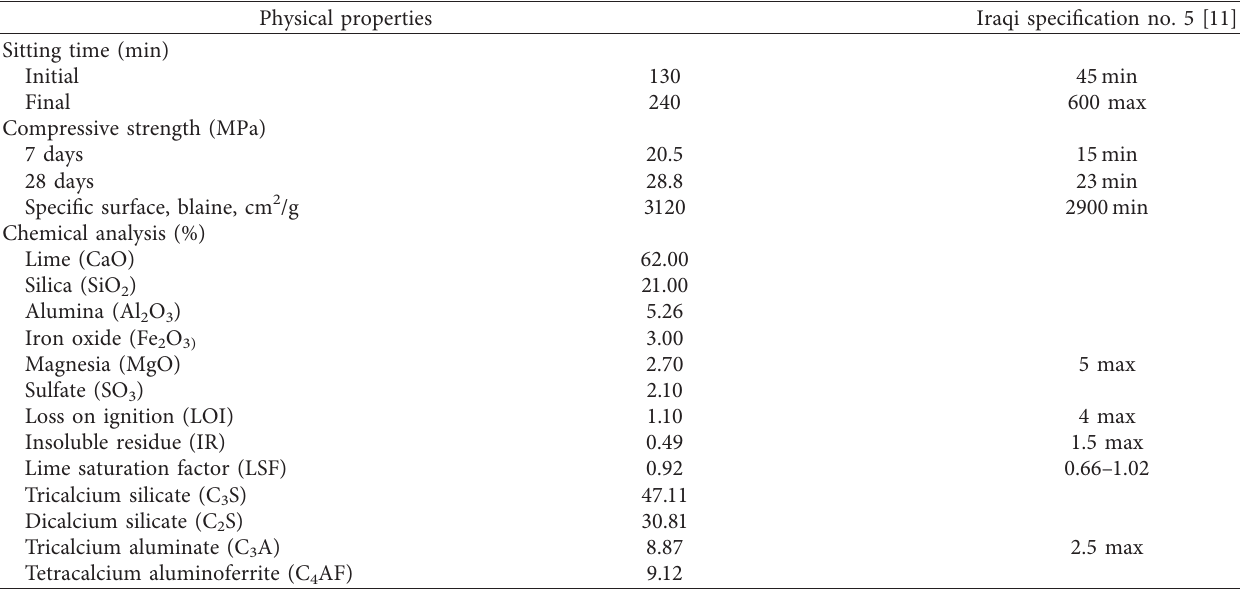
Table 2: Physical properties and chemical composition of the used